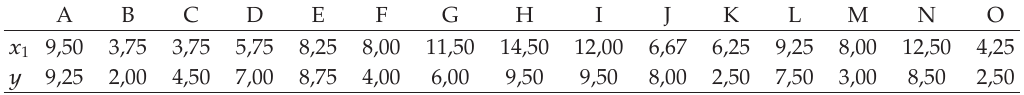
Table 1: Data for the single input single output case.